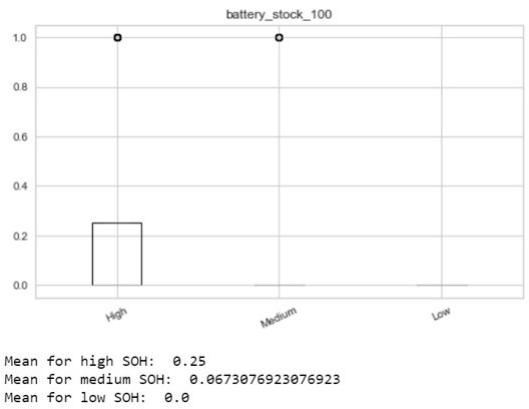
Figure 14. KPI behavior for trucks classified according to their battery health status.